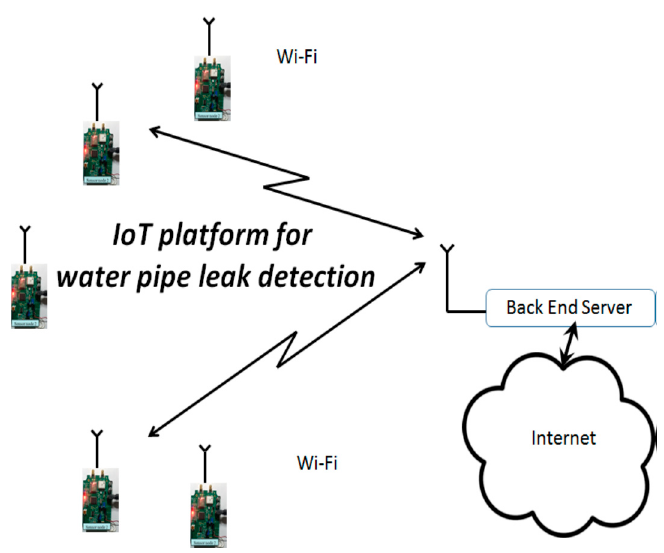
Figure 6. IoT wireless sensor platform.